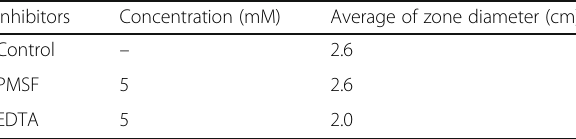
Table 3 Effect of various inhibitors on purified